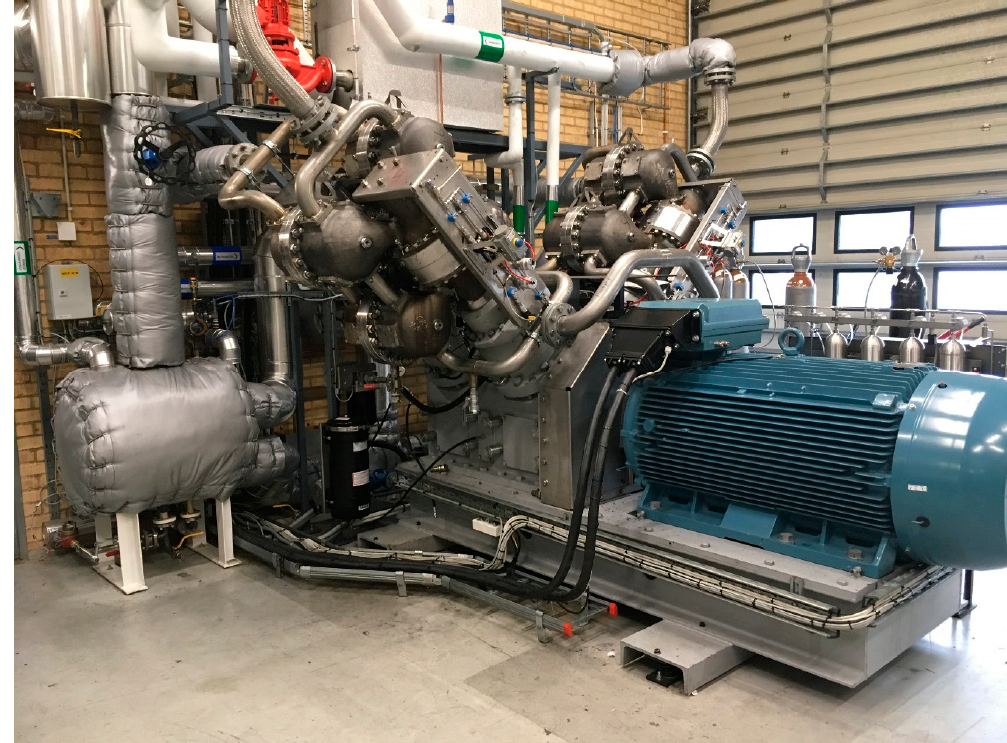
Figure 1. The HighLift HTHP from Olvondo Technology installed in the heat pump room at pharmaceutical company AstraZeneca, Gothenburg, Sweden. The nominal heat output from the heat pump is between 450 and 500